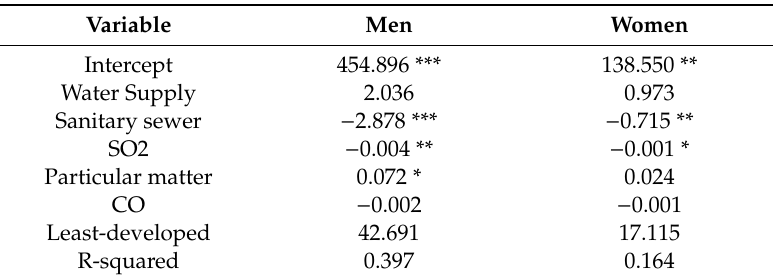
Table 2. Estimated cross-sectional models.